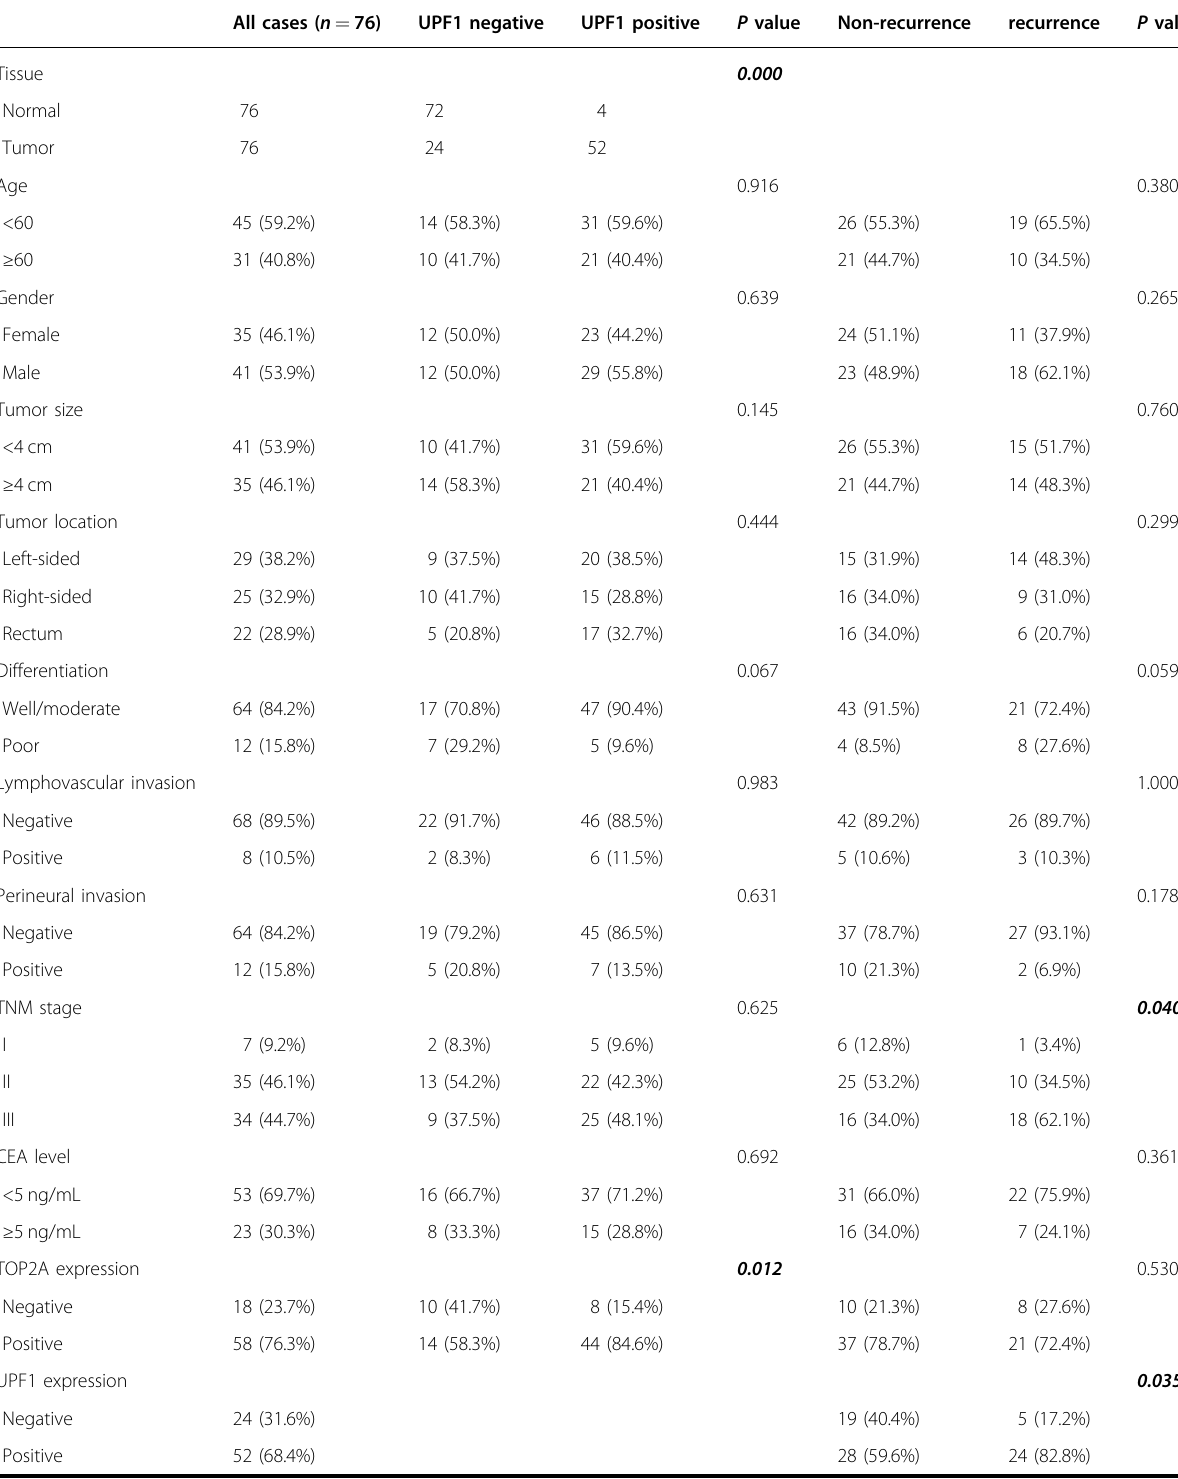
Table. 1 Clinicopathological characteristics of CRC patients according to UPF1 or recurrence